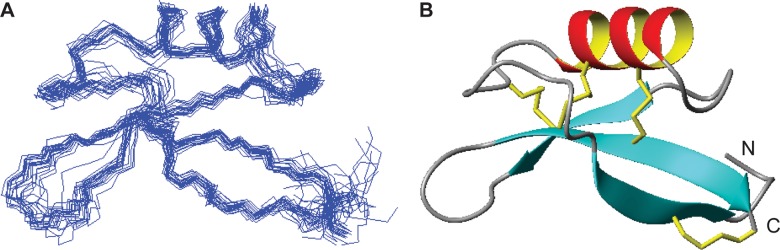
Three-dimensional structure of rHsAFP1.(A) A family of 20 lowest energy structures superimposed over all backbone heavy atoms; (B) A ribbon representation with disulfide bonds shown in yellow. The termini are labeled as N and C. Diagrams were generated using MOLMOL.